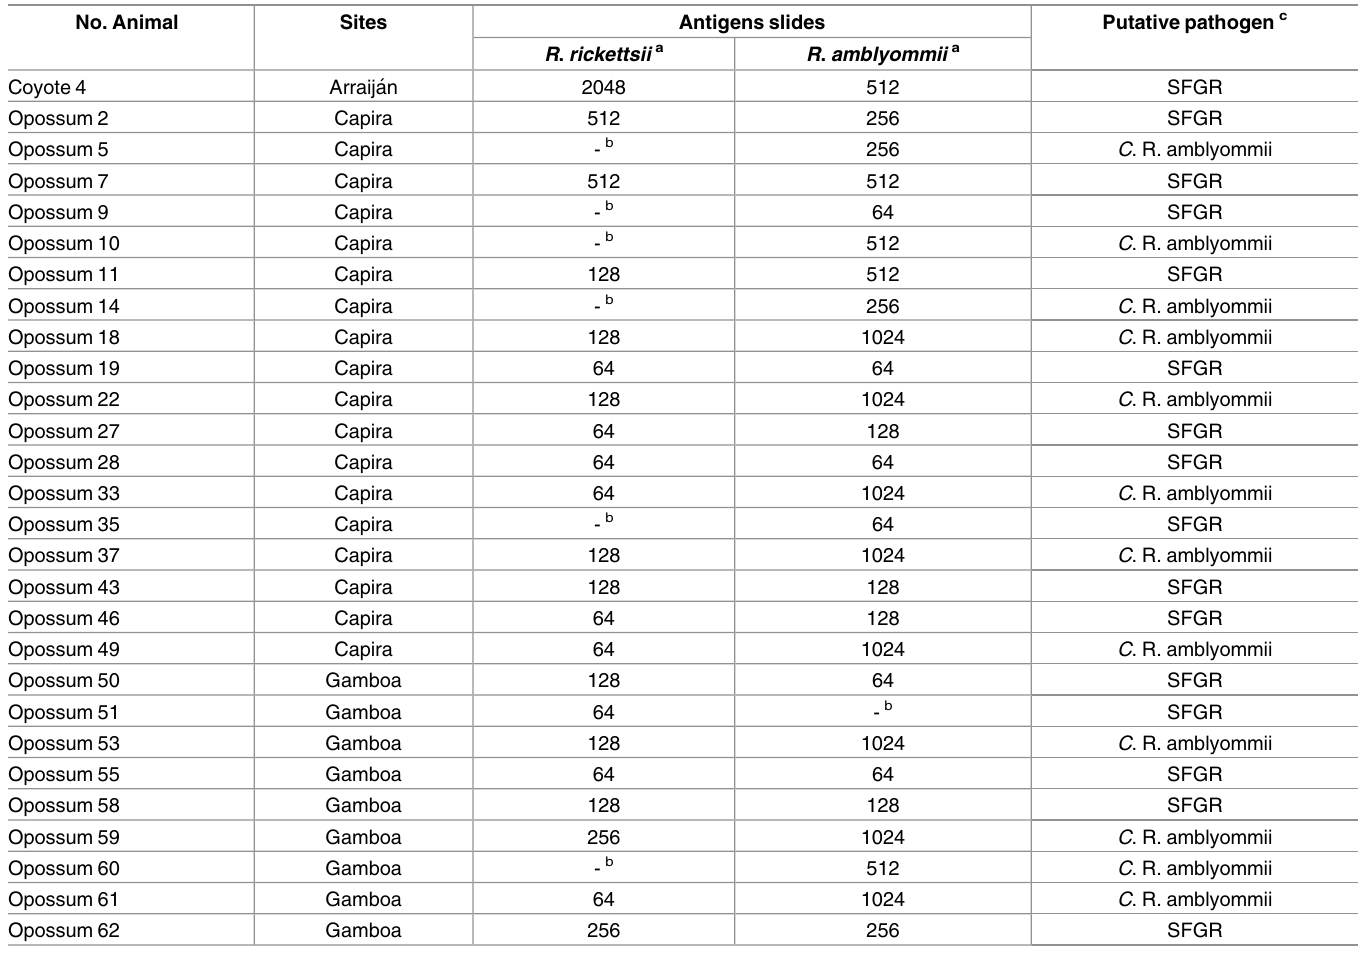
Table 2. IFA reactivity of coyote and opossum serum samples to SFGR. No.